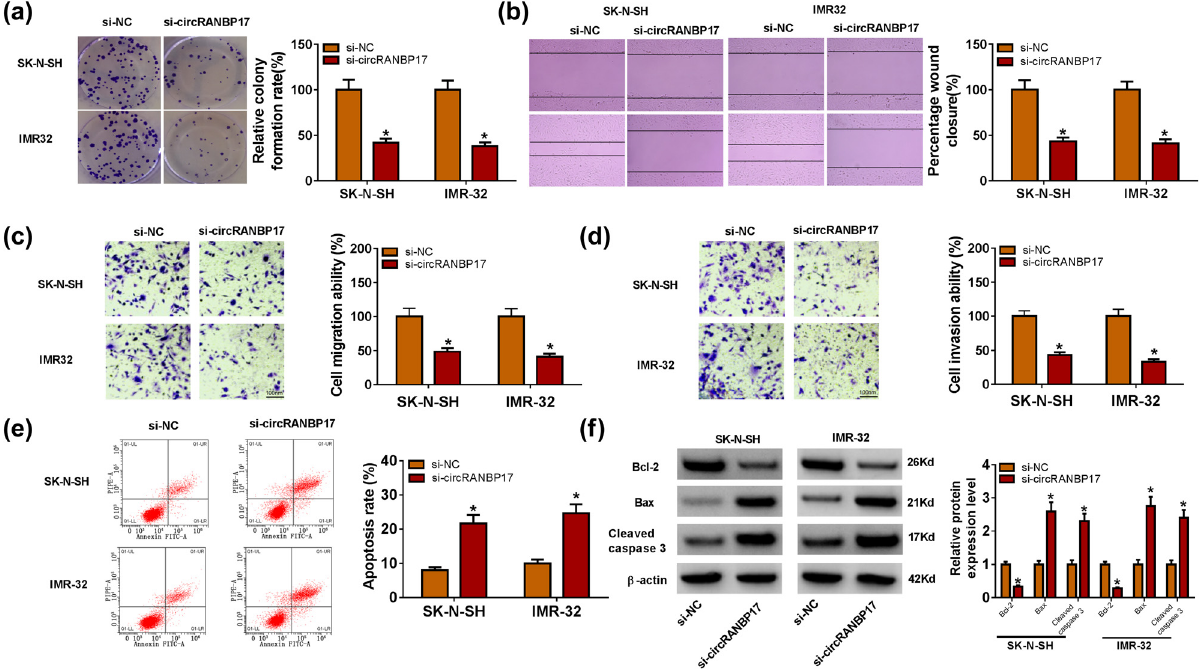
Figure 3: CircRANBP17 knockdown restrains cell migration and invasion and induces cell apoptosis in SK - N - SH and IMR - 32 cells. The cell proliferative capacity ( a ) , cell migration and invasion ability ( b – d ) , and apoptosis rate ( e ) in SK - N - SH and IMR - 32 cells transfected with si - circRANBP17 or si - NC were assessed by cell colony formation assays, wound - healing and Transwell assays and fl ow cytometry, respectively. The protein levels of Bcl - 2, Bax and Cleaved caspase 3 were measured by western blot ( f ) . * P <